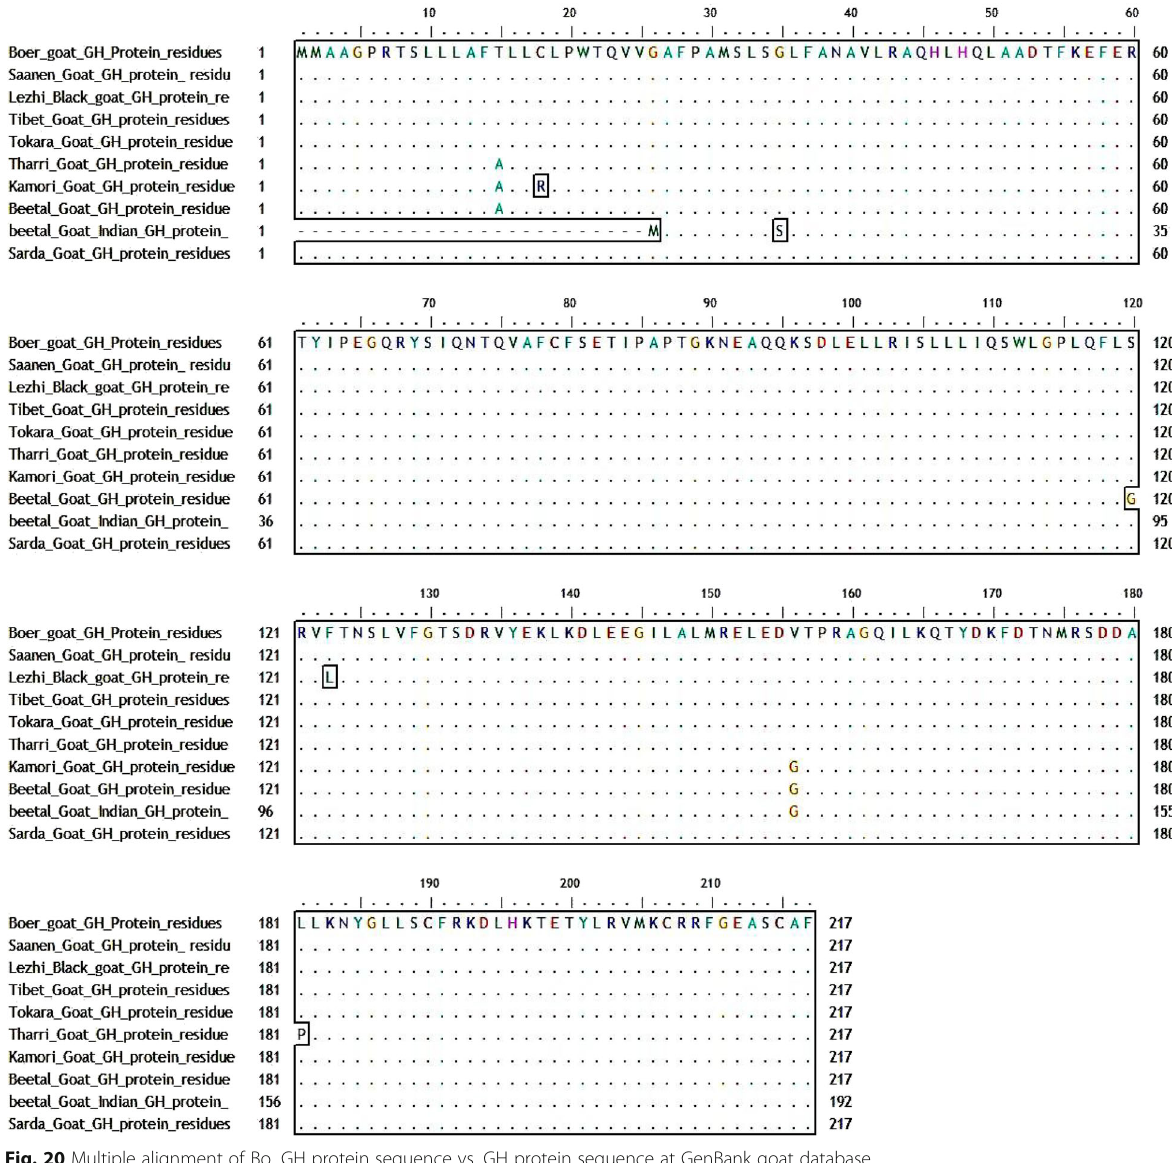
Fig. 20 Multiple alignment of Bo_GH protein sequence vs . GH protein sequence at GenBank goat